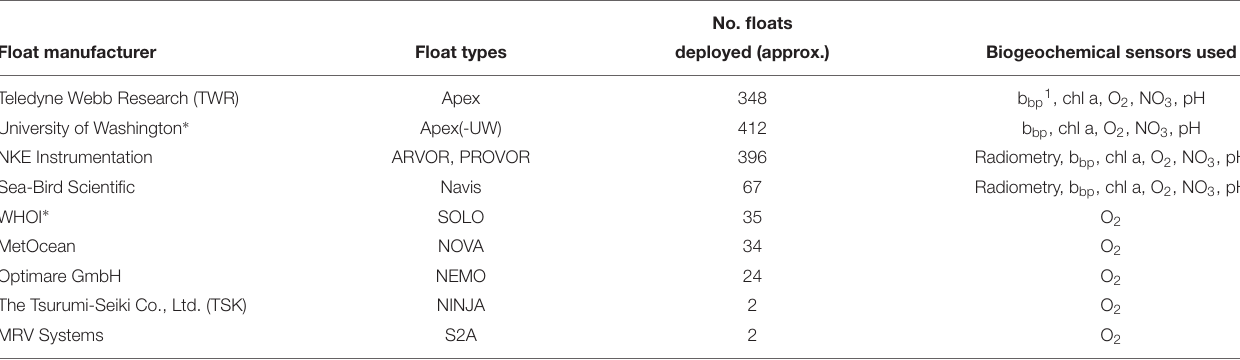
TABLE 1 | Distribution of currently deployed BGC-Argo floats (as of January 2019) by float manufacturer/float type with list of biogeochemical sensors that have been used on these floats (not always concurrently). Information are compiled from AIC/JCOMMOPS and GDAC meta data. No.